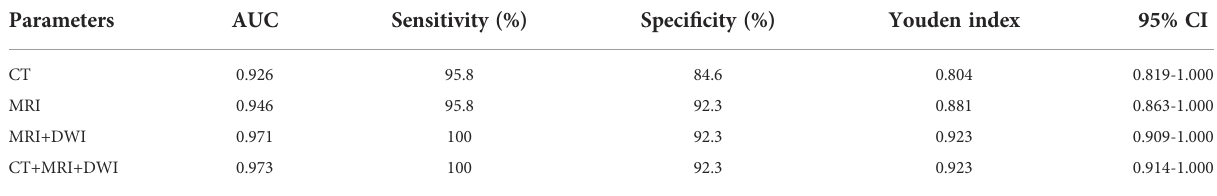
TABLE 4 Diagnostic performance of characteristics of lesions on CT and MRI including DWI images in differentiating benign cystic renal masses from malignant.